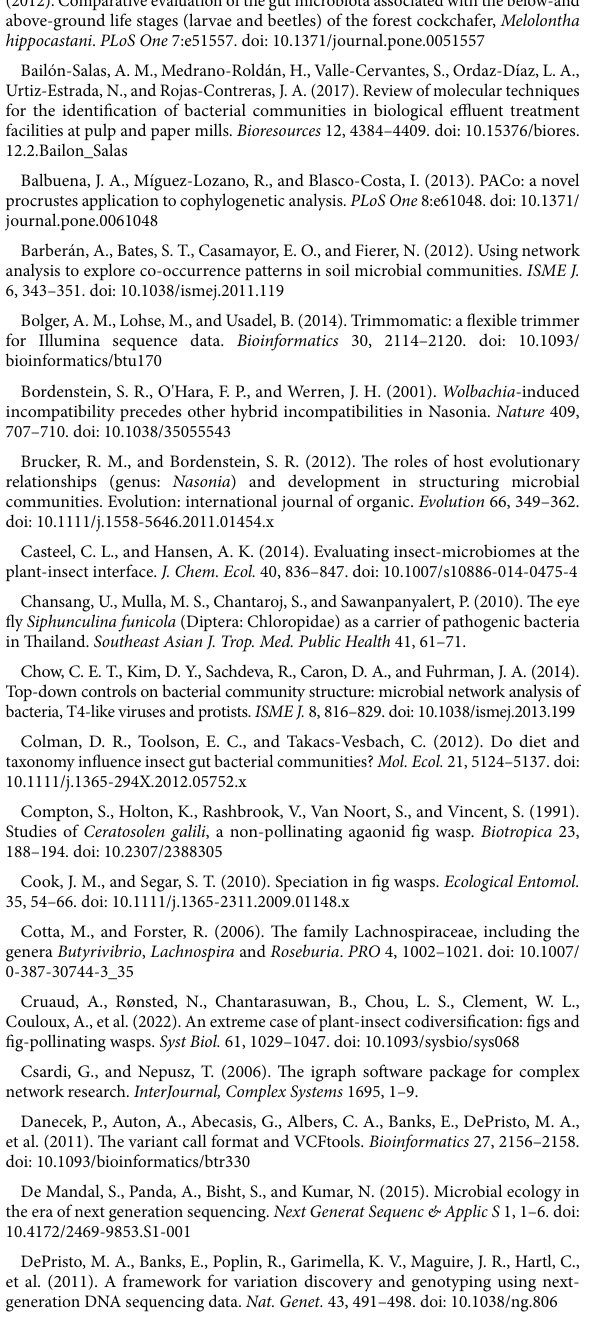
SUPPLEMENTARY FIGURE S8 Heatmap of the functional groups obtained from FAPROTAX for each sample of bacterial community. The color bar reflects the value of functional abundance. Fa_C represents the cheater of F. altissima ; Fa_P represents the pollinator of F. altissima ; Fm_C represents the cheater of F. microcarpa ; Fm_P represents the pollinator of F. microcarpa